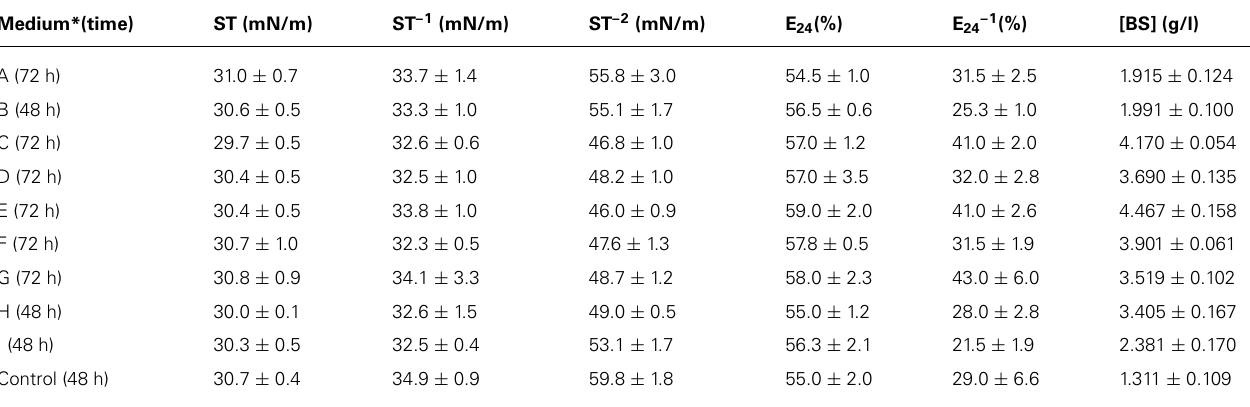
Table 3 | Surface tension values [ST, ST –1 , and ST –2 (mN/m)], emulsifying indexes [E 24 , E 24–1 (%)] and biosurfactant concentrations obtained in cultures performed with B. subtilis #573 grown in CSL 10% supplemented with different metals at different concentrations.